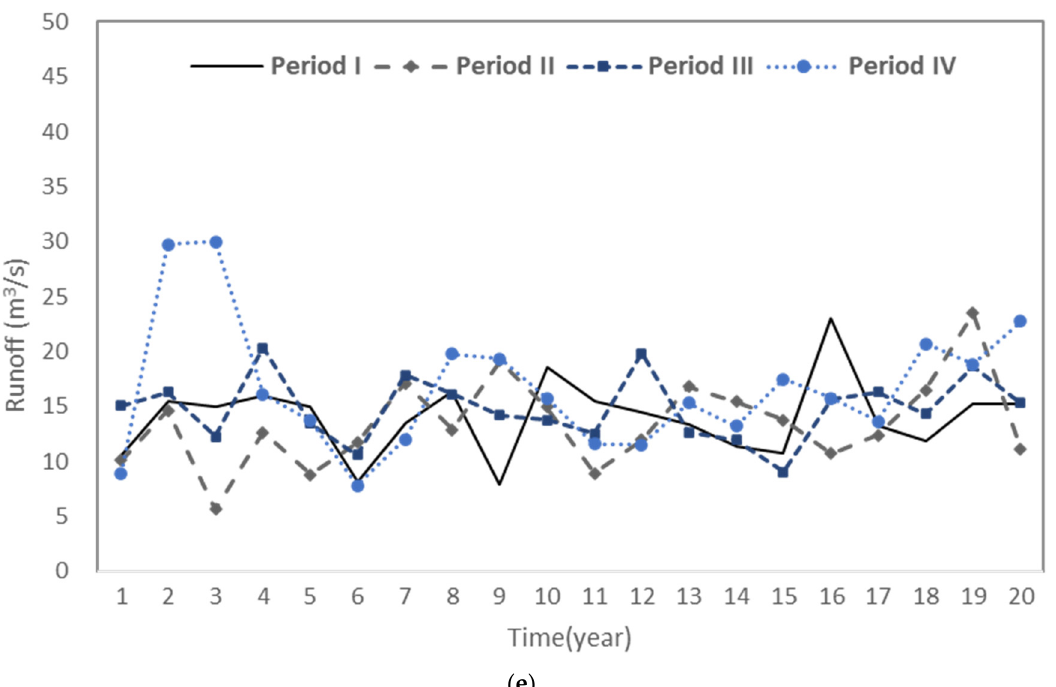
Figure 6. Future discharge simulation results of the Socheon SHP plant basin. ( a ) Monthly average discharge: Period I (2021–2040), ( b ) monthly average discharge: Period II (2041–2060), ( c ) monthly average discharge: Period III (2061–2080), ( d ) monthly average discharge: Period IV (2081–2100), ( e ) annual average discharge. Table 7. Future runoff statistics in the Socheon SHP plant basin, [Unit: m (cid:2871) /s ].